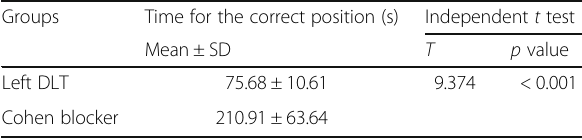
Table 2 Number and percentage of intubation attempts Number of intubation